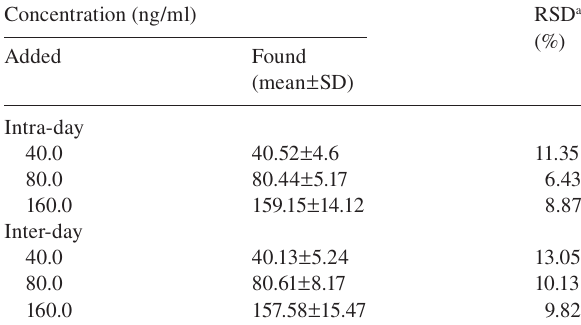
Intra-day and inter-day precision and accuracy of